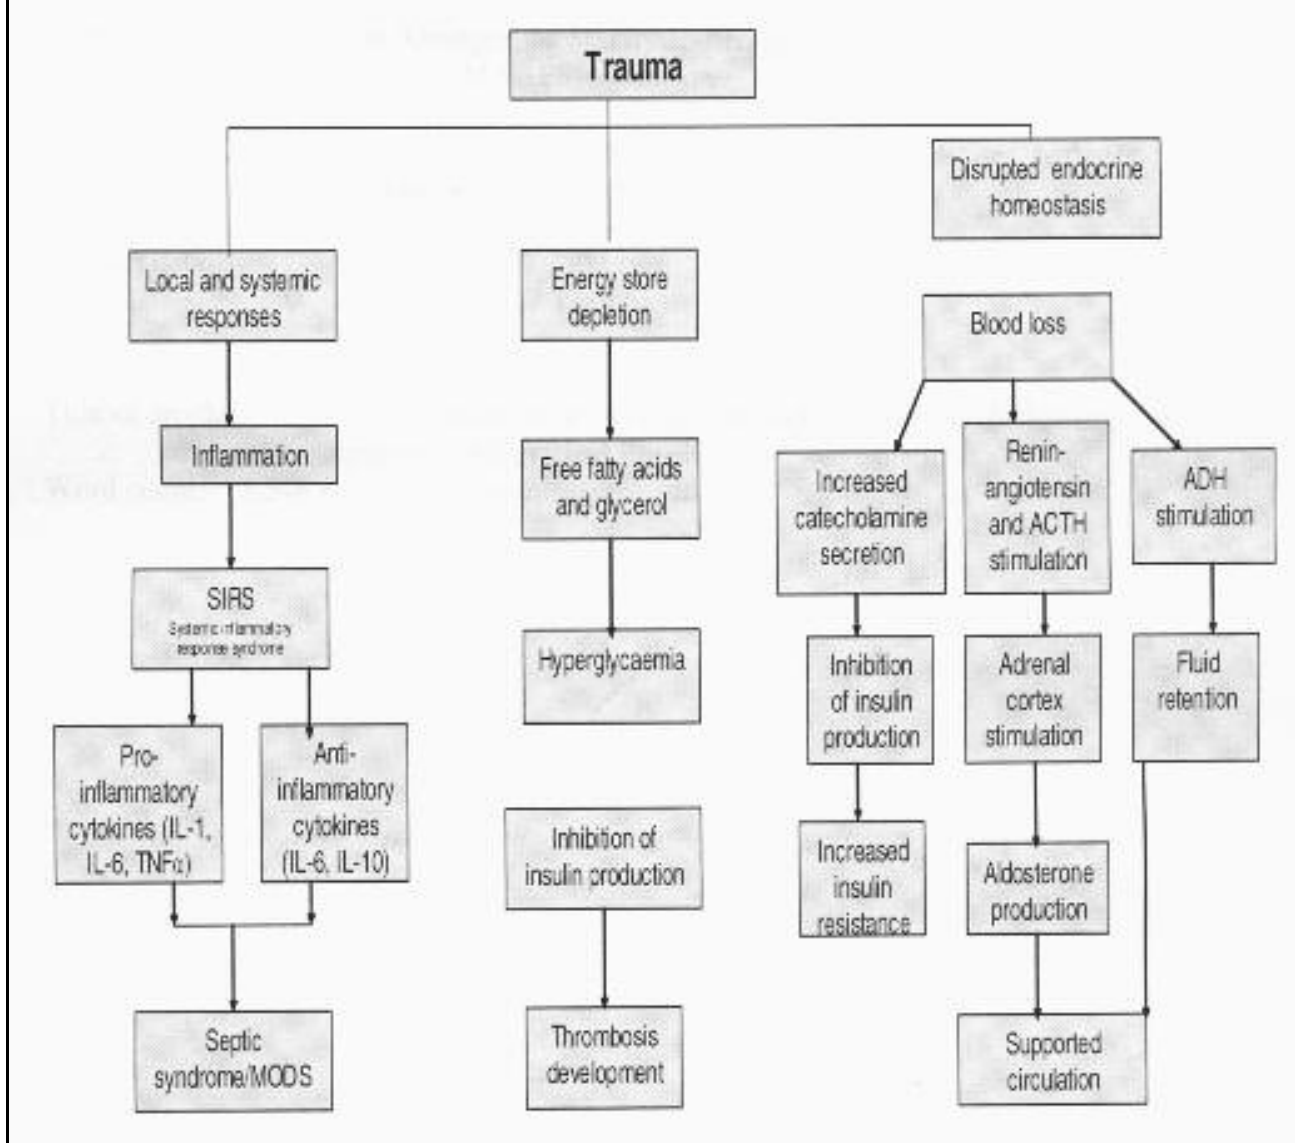
Figure 1: Schematic representation of the response to